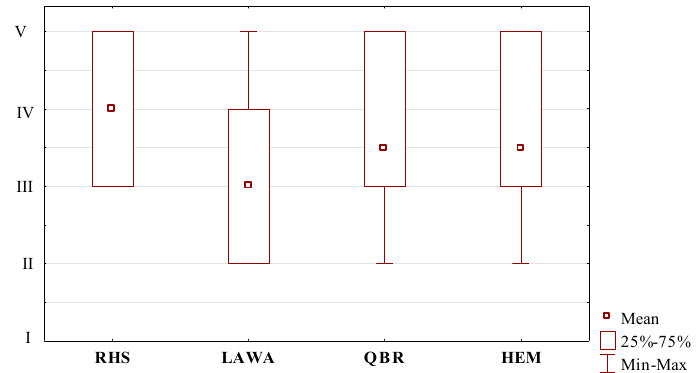
Figure 4. Graphical interpretation of hydromorphological state class distribution based on RHS, LAWA, QBR, and HEM methods.